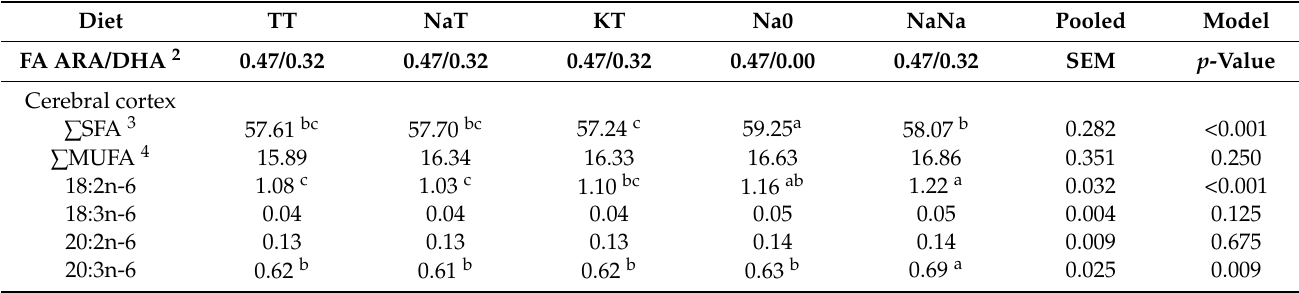
Table 5. Select cerebral cortex and retina FA concentrations of pigs receiving experimental milk replacers with different sources of ARA (% of total measured FA) 1